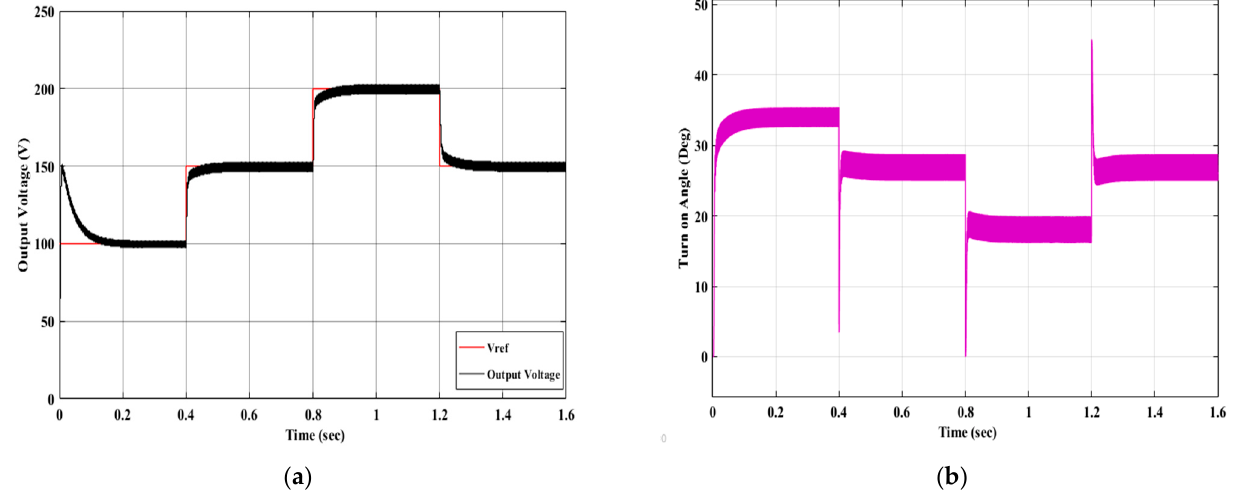
Figure 12. The transient response of turn-on angle control, ( a ) different reference output voltage (v), ( b ) the corresponding generated turn-on angle in deg.